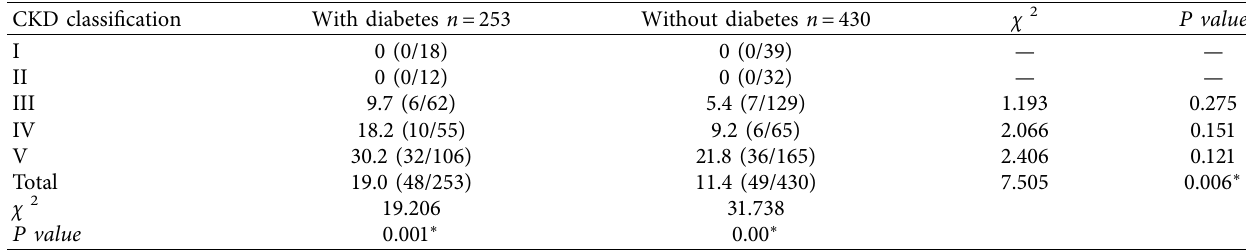
Table 4: Prevalence of severe malnutrition in CKD patients with or without diabetes in different stages ( n (%)). CKD classification With diabetes n �